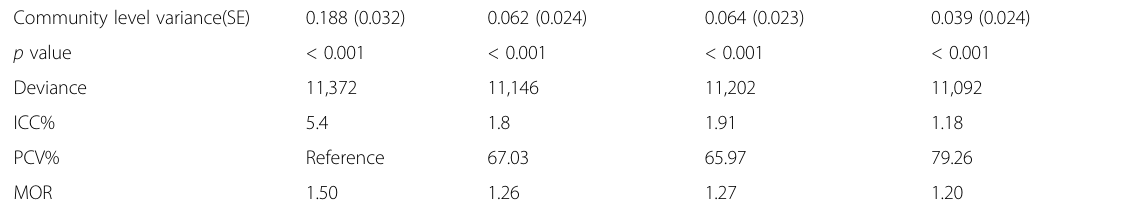
Random effects (effects of variation), i.e, measure of variation for high-risk fertility